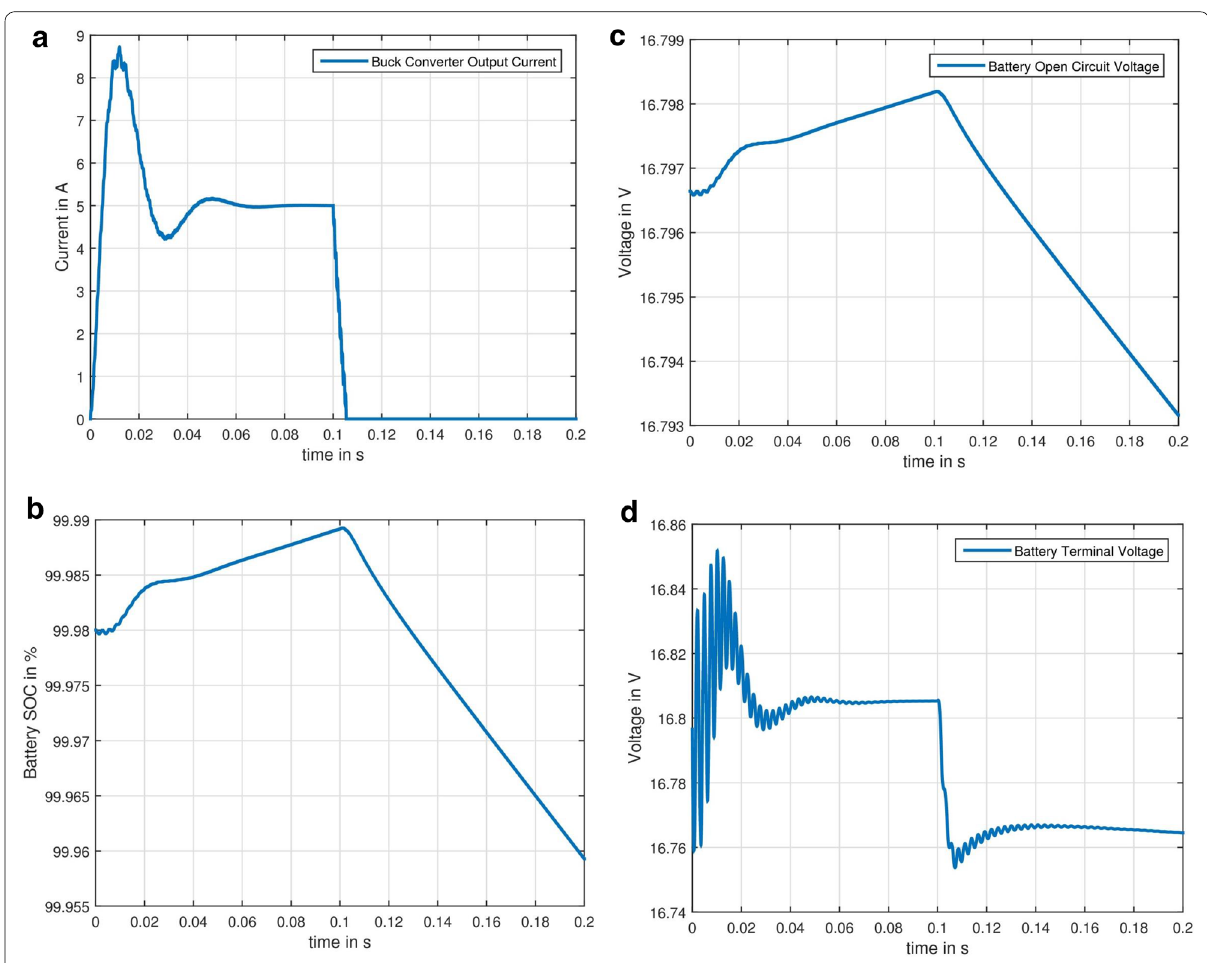
Fig. 6 a Battery current input during charging (negative) and output while discharging (positive). b Battery SOC during charging (rising) and discharging (falling). c Battery open circuit voltage during charging (rising) and discharging (falling). d Battery terminal